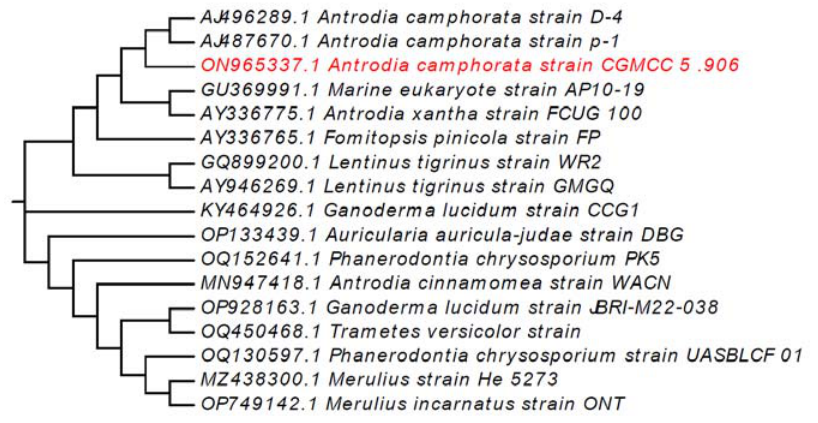
Figure 2. ITS gene sequence-generated phylogenetic tree.